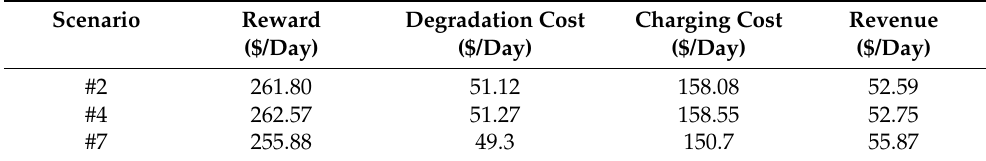
Table 3. The reward, degradation cost, charging cost, and